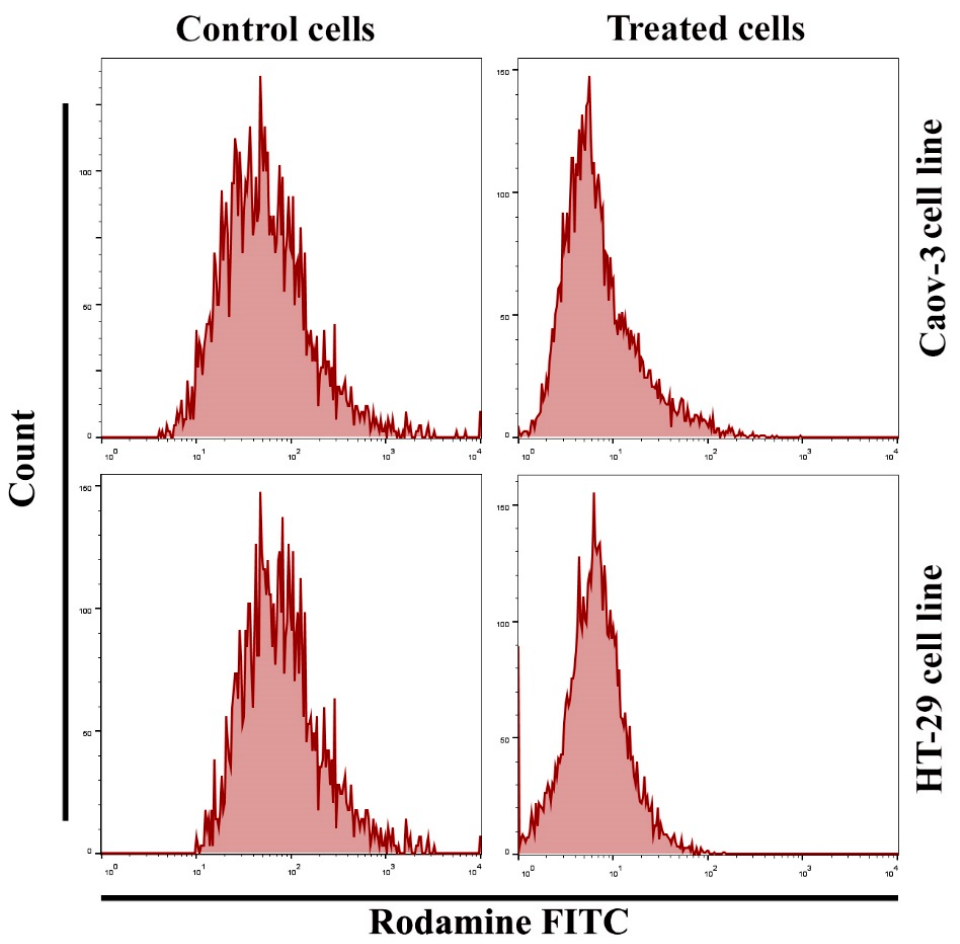
Figure 5. Effect of cisplatin on the loss of mitochondrial membrane potential.